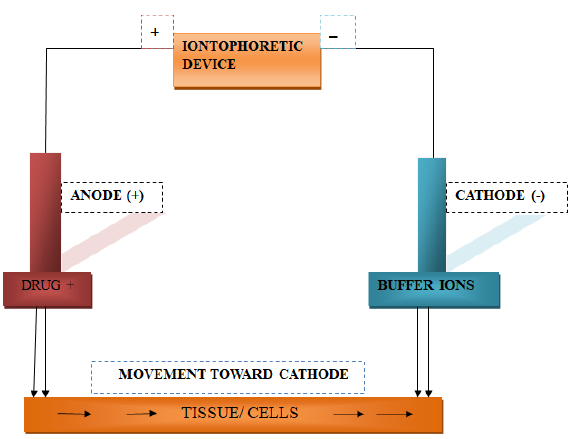
Fig. 12. Schematic representation of iontophoretic delivery Focused Ultrasound (FUS) Technique